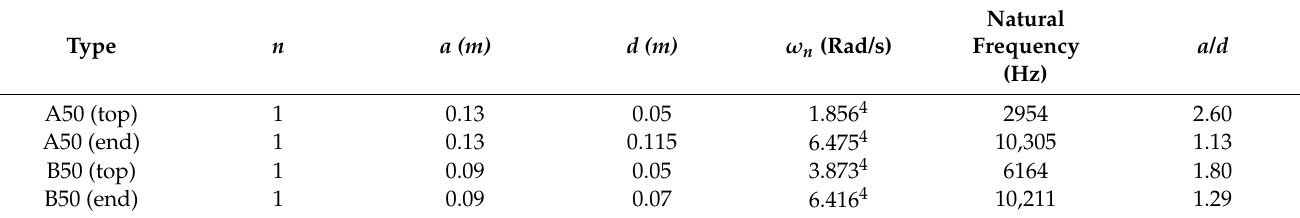
Table 2. Summary of information for natural frequency